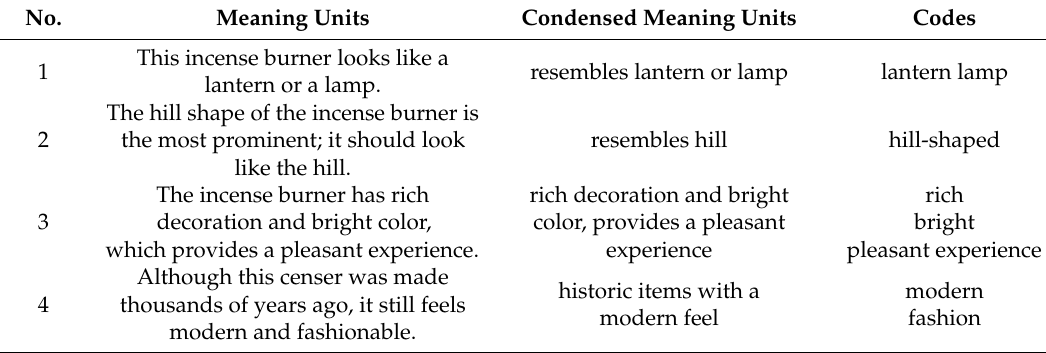
Table 2. Analysis of Pleasant Features in Hill